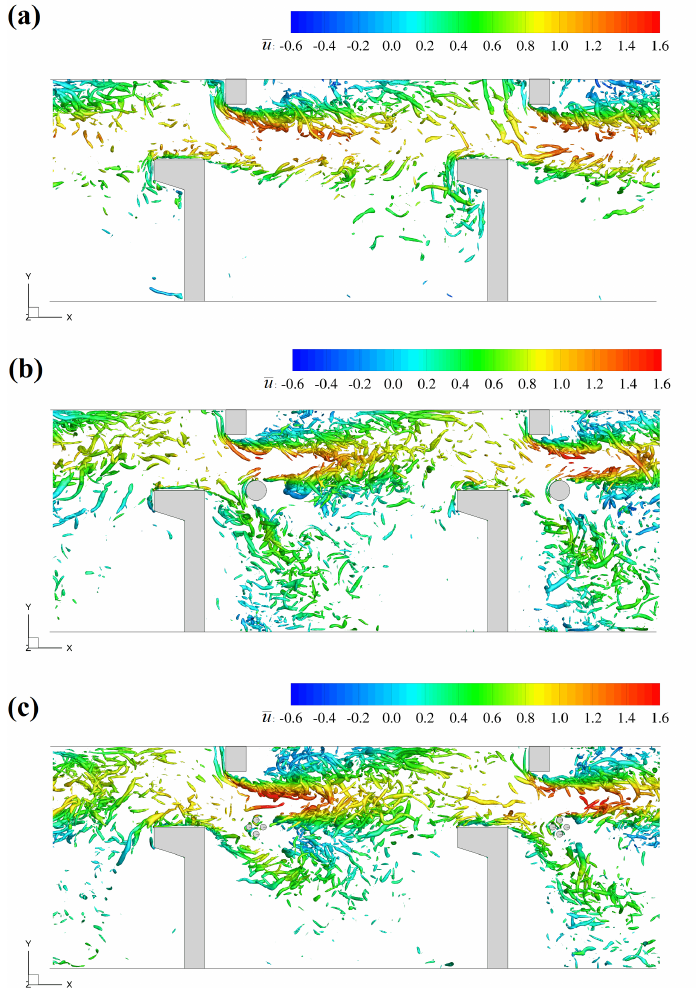
Figure 9. Visualization of the coherent structures using the Q criterion colored by time-averaged streamwise velocity: ( a ) Case 1; ( b ) Case 2; ( c ) Case